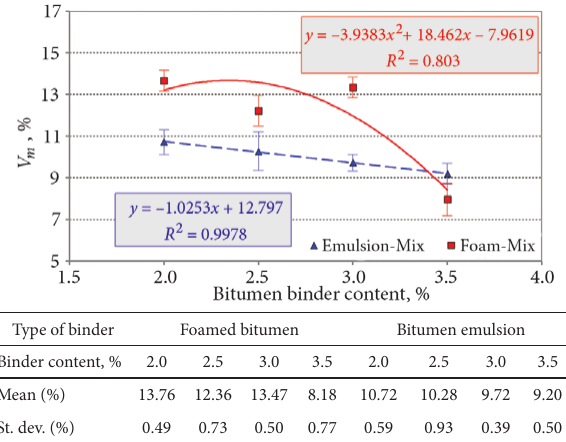
Fig. 3. The impact of the bitumen binder content on air void content (the error bars represent the standard deviation)